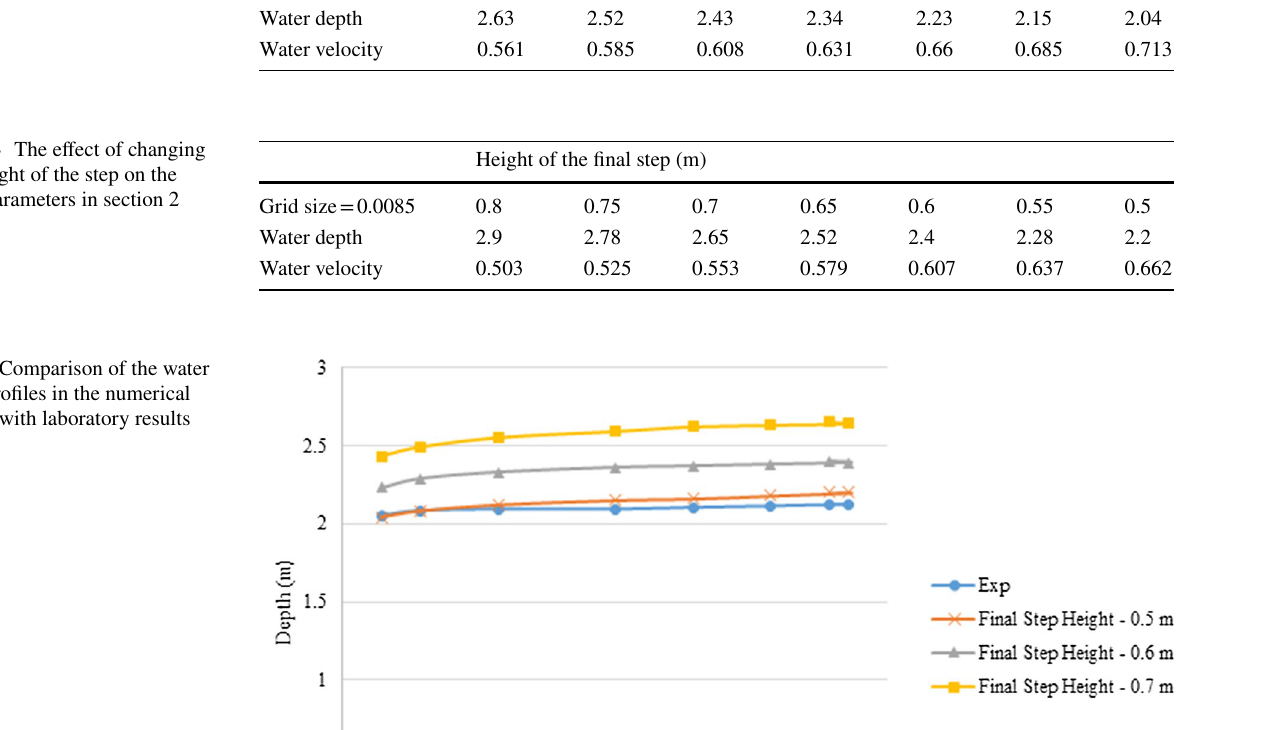
Table 3 The effect of changing the height of the step on the flow parameters in section 1